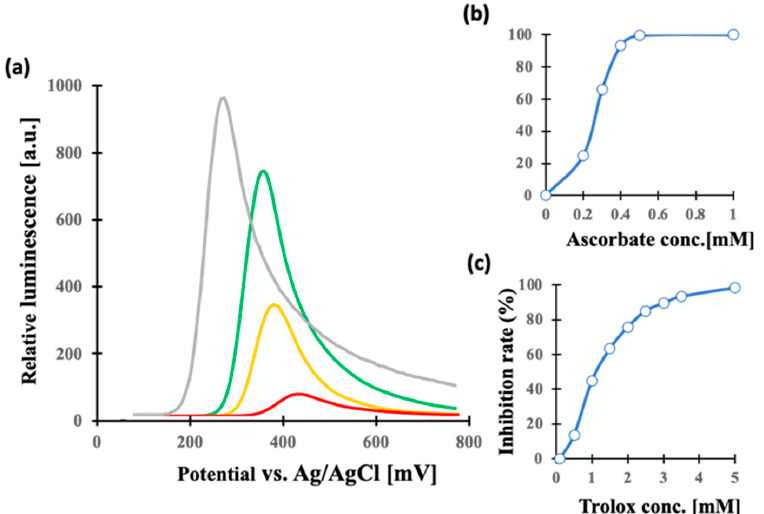
Figure 2. Antioxidant activity was determined using luminol electrochemiluminescence as de- scribed in the text. Luminescence-potential profiles ( a ) were obtained with different concentrations of ascorbic acid: 0 mM (grey), 0.2 mM (green), 0.3 mM (yellow), and 0.4 mM (red). Luminescence inhibition rate (%) was calculated using the formula: [1 − (luminescence at zero concentration − luminescence of sample)/(luminescence at zero concentration)] × 100 (%). Luminescence inhibition rates are plotted against the concentrations of ascorbic acid ( b ) and trolox ( c ).